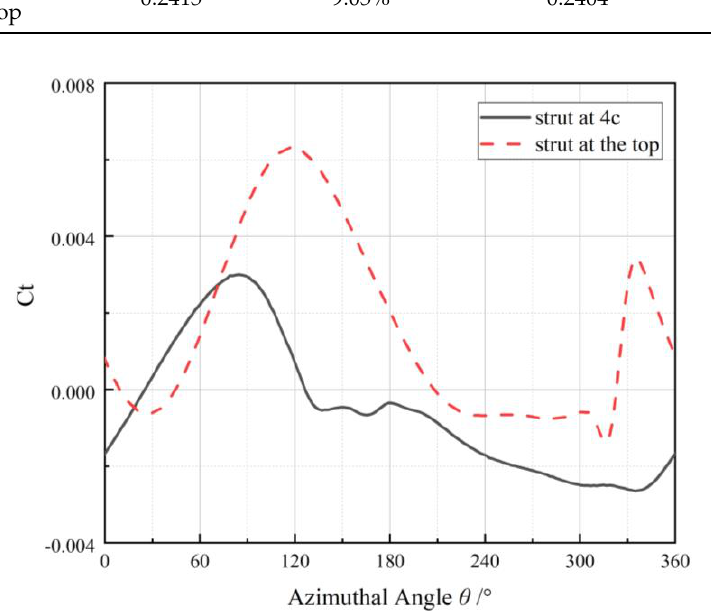
Figure 21. Instantaneous torque of the supporting strut at the top and at the height of 4c.